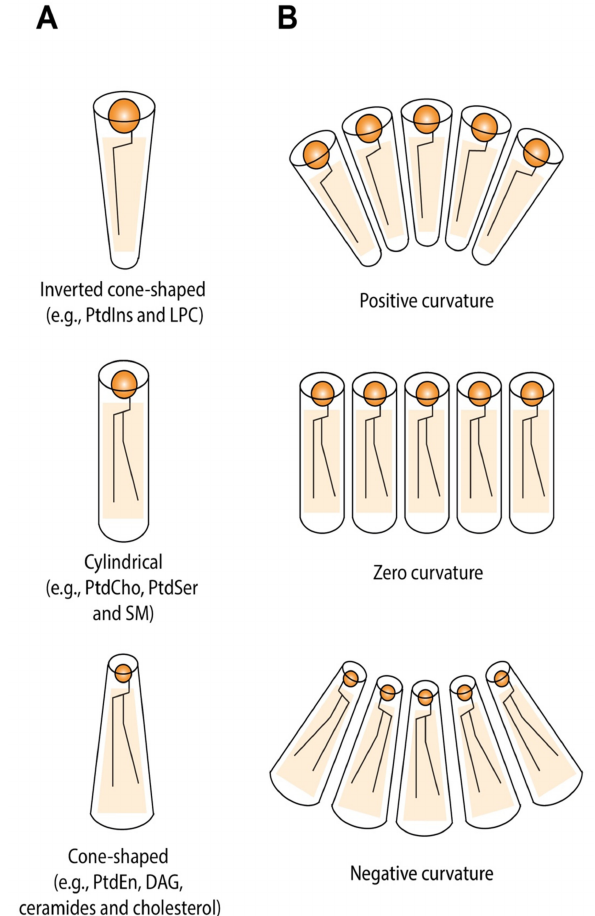
Figure 3. Membrane curvature depends on the shape of the constituent lipid species. ( A ) The molec- ular geometry of membrane lipids depends on the cross-sectional area of the lipid headgroup versus the three-dimensional volume occupied by the hydrophobic acyl chain. Lipids with a large headgroup are defined as inverted cone-shaped, lipids like PtdCho are roughly cylindrical, while lipids with small headgroup relative to a larger hydrophobic part are cone-shaped. ( B ) Lipid geometry influences membrane curvature. Cone-shaped and inverted cone-shaped lipids self-assemble into monolay- ers with negative and positive curvature, respectively, while monolayers consisting of cylindrical lipids exhibit zero curvature. PtdIns, phosphoinositol; LPC, lysophosphatidylcholine; PtdCho, phos- phatidylcholine; PtdSer, phosphatidylserine; SM, sphingomyelin; PtdEtn, phosphatidylethanolamine; DAG,